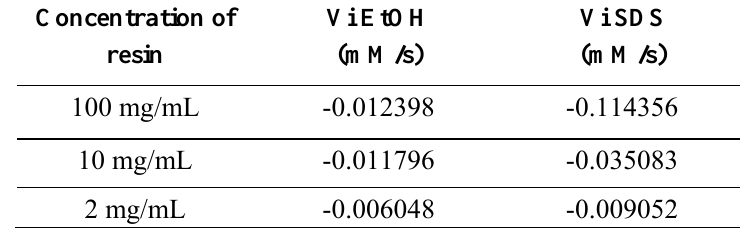
Table 2. Initial rate for the reaction of DPPH radical with the resin of Heliotropium taltalense in homogenous system (EtOH) and microheterogenous system (SDS). Concentration